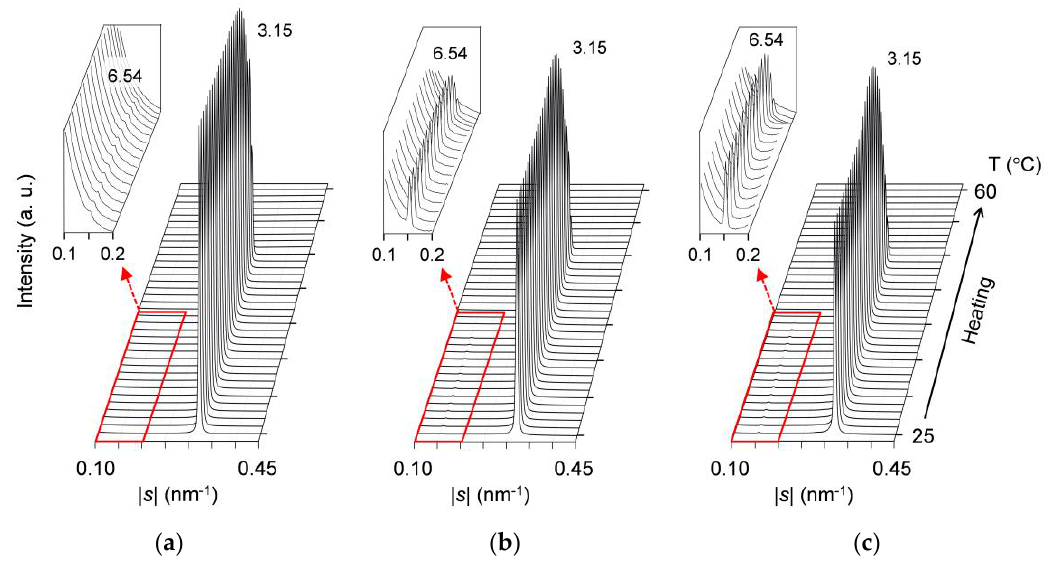
Figure 8. Time-resolved SAXS profiles of 25 °C-aged SOS/LLL, taken during heating at a rate of 5 °C/min: ( a ) w LLL = 0.975; ( b ) w LLL = 0.950; ( c ) w LLL = 0.925. Insets depict the profiles with 150× magnified intensity. Unit: nm.